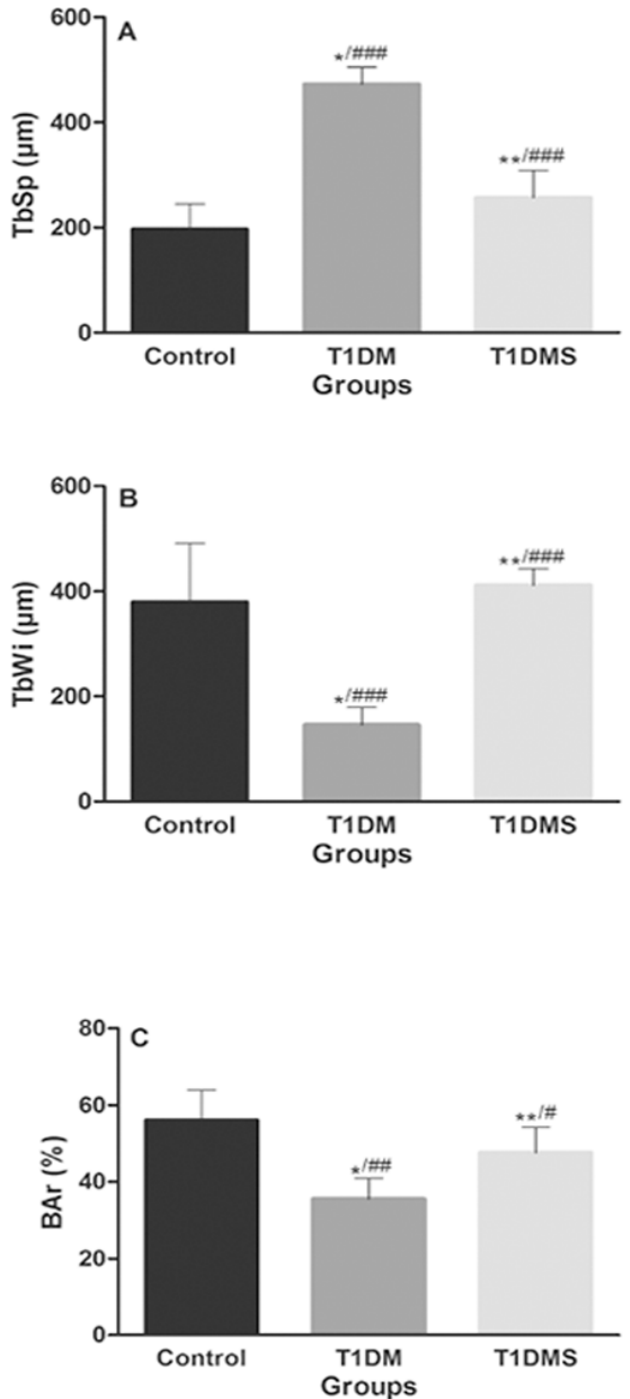
Fig 2. Histomorphometric analyses of structural bone architecture. Trabecular separation (TbSP, μ m) (A), trabecular width (TbWi, μ m) (B), and trabecular bone area (BAr, %) (C) of control, type 1 diabetes mellitus (T1DM), and T1DM plus zinc supplementation (T1DMS) rats. All data are shown as means ± SEM. Comparisons between groups were analyzed with Kruskal-Wallis ANOVA on Ranks and Dunn ’ s post-hoc. p < 0.01 * /## vs. control group; p < 0.001 * /### vs. control group; p < 0.05 ** /# vs. T1DM group; p < 0.001 ** /### vs. T1DM